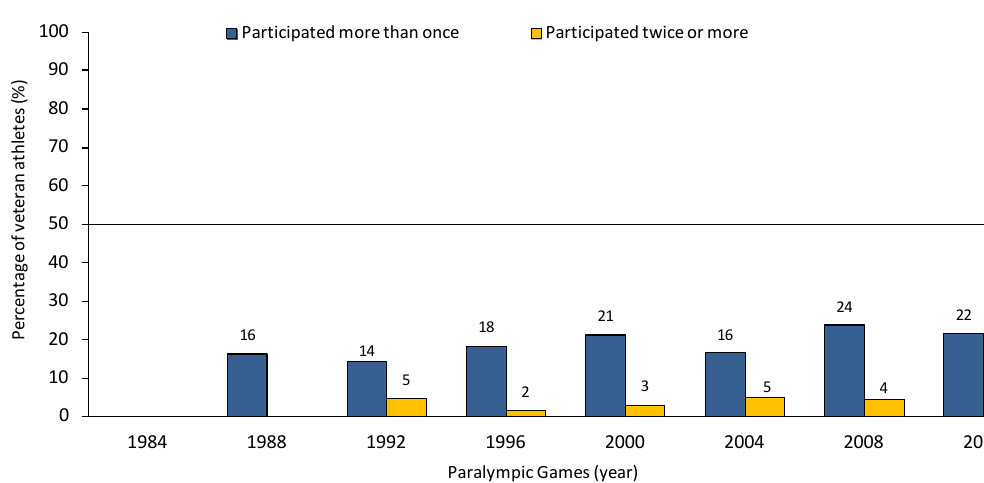
Figure 5. Veteran Brazilian Paralympic athletes returning more than once, and more than twice, to the Games. Participation from 1984 until 2012. (These data are subject to inaccuracies, as the precise number of athletes is unknown, especially in the early years of the Games. Some of the athletes’ names were misspelled or omitted from the IPC database) 9